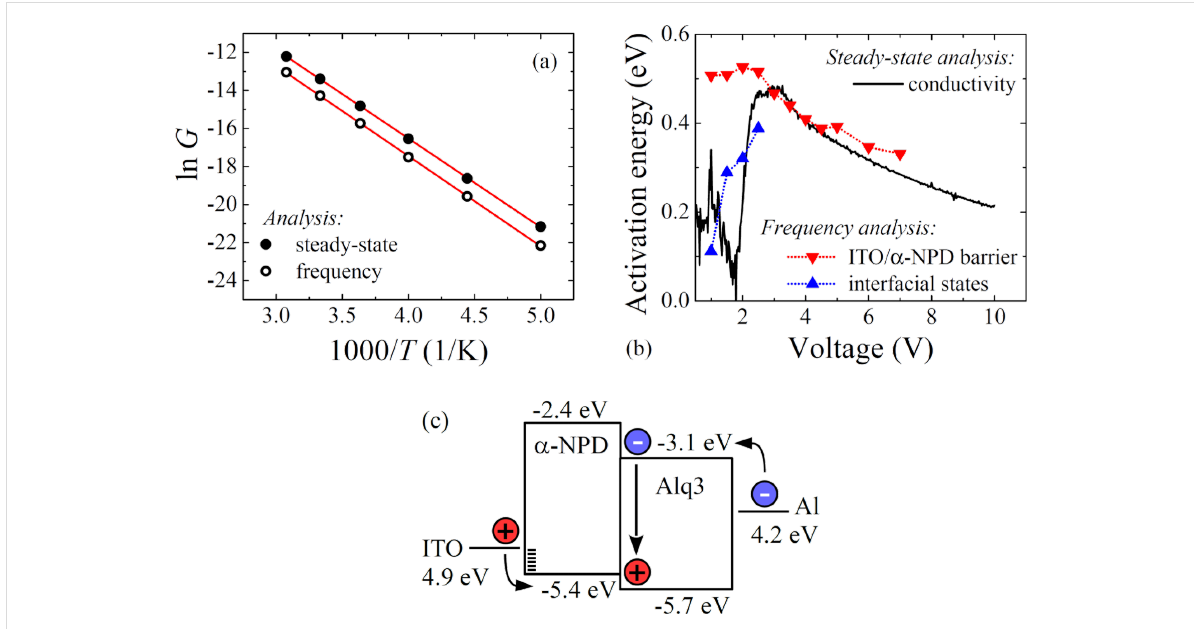
Figure 5: (a) Arrhenius plot of conductivities estimated from steady-state current density–voltage measurement and impedance spectroscopy spectra at voltage bias of 4 V and (b) evaluated voltage dependence of activation energies. (c) Energy band diagram model.